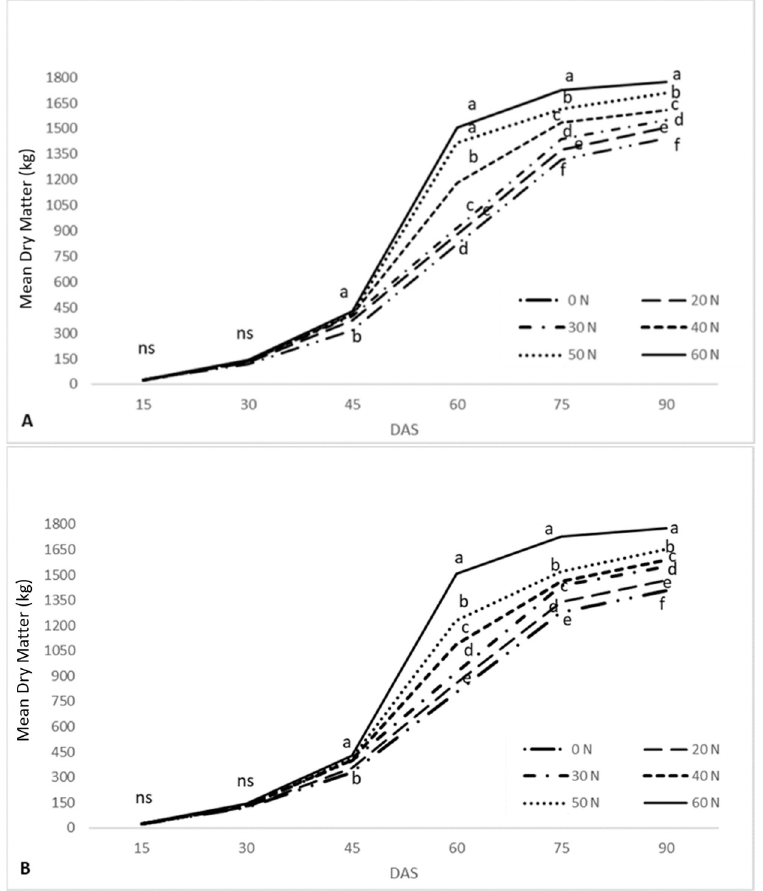
Figure 1. Changes in DM at different DAS (“ns”: not statistically significant at p = 0.05; different letters are significantly different at p = 0.05), during 2018 ( A ) and 2019 ( B